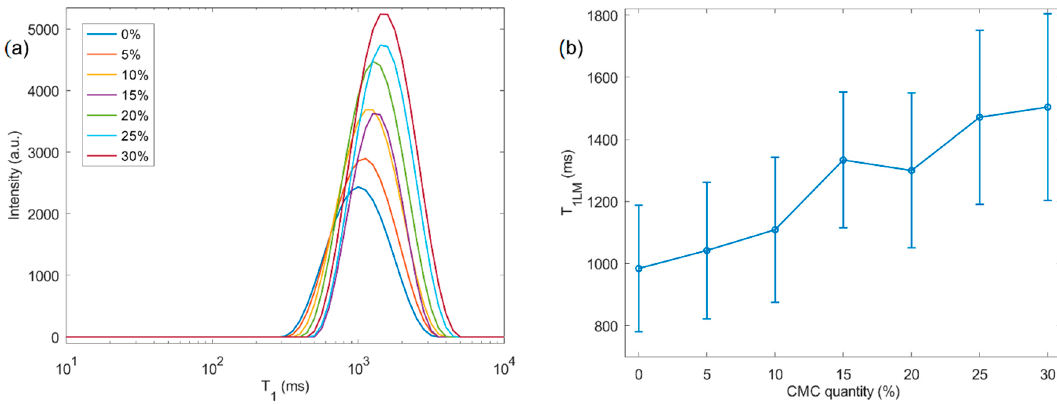
Figure 2. 1 H NMR longitudinal relaxation measurements. ( a ) T 1 time distributions from the cellulose-based samples for various % of CMC (in legend), showing an increase in both intensity and T 1 relaxation time. This is also shown in ( b ) by plotting the log-mean T 1 values, calculated from the T 1 distributions, as a function of CMC percentage. Error bars indicate the width of the distribution.